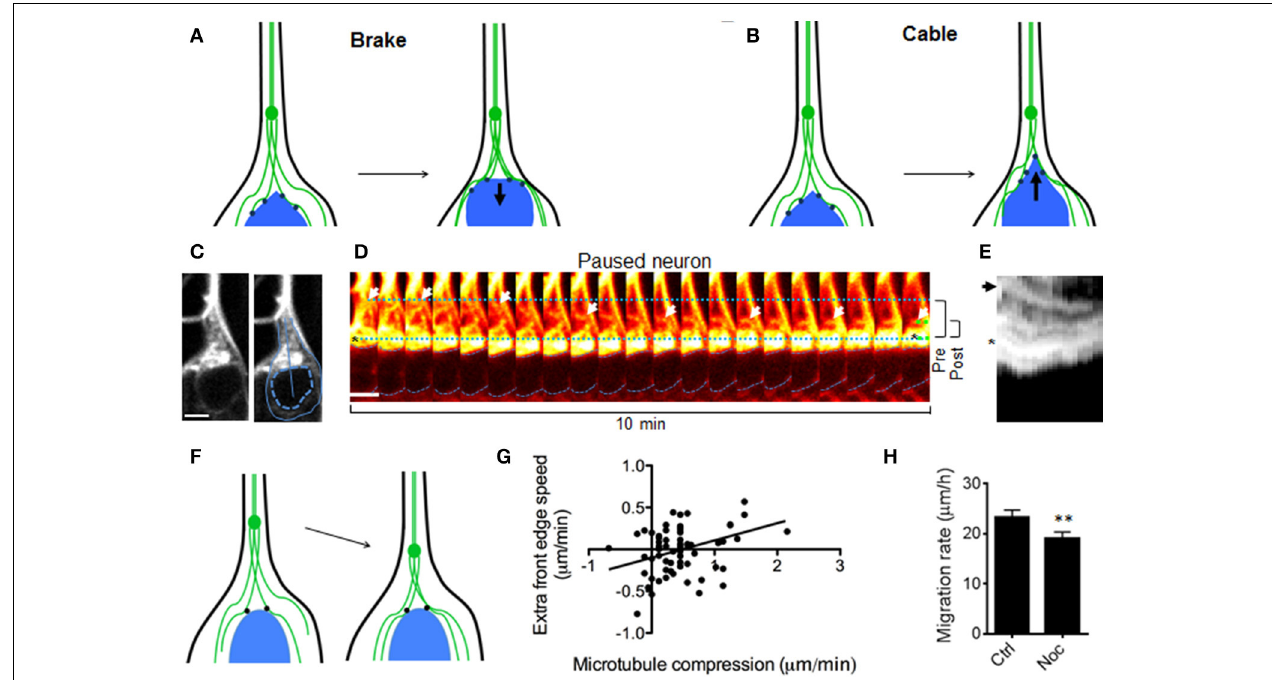
FIGURE 2 | Models to explain convergence between nucleus and leading process microtubules. (A) Testable model 1 (“Brake”): Microtubules act as a brake. Nucleokinesis is due to pushing forces from behind that cause the nucleus to “crash” against leading process microtubules. Leading process microtubules (green) form a barrier that slows (resistive force shown as arrow) the front edge of the nucleus (blue) as these compress together. In this model microtubule convergence and excess speed of the front edge are inversely correlated, and this convergence only occurs during nucleokinesis. (B) Testable model 2 (“Cable”): Microtubule motor proteins (black dots) draw the nucleus forward along the leading process microtubules, which can be thought of as cables or rails, as in other cell types (Zhang et al., 2009). The pulling force (arrow) from in front of the nucleus draws the front edge along microtubules faster than the center, causing elongation of the nucleus. In this model, microtubule/soma convergence and excess speed of the front edge are directly correlated, and convergence may also occur in GnRH neurons that have stalled. ( C , left) Fluorescent staining of microtubules in a GnRH neuron that is not migrating. ( C , right) Outlines indicate the border of the cell (solid) and nucleus (dotted),